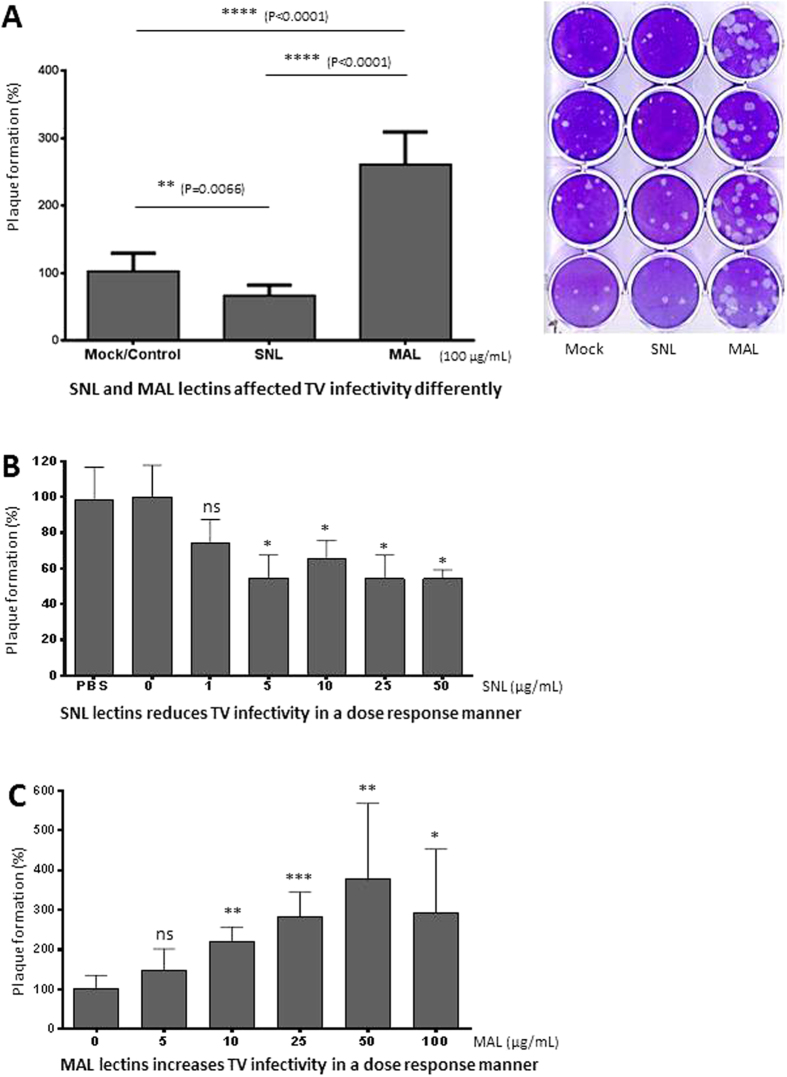
Sialic acid (SA)-binding lectins affected Tulane virus (TV) infectivity differently.(A) Sambucus nigra lectin (SNL) inhibited, while Maackia amurensis leukoagglutinin (MAL) increased TV infectivity in LLC-MK2 cells. Prior to TV infection, the LLC-MK2 cells were treated with SA-binding lectins; 100 μg/mL of SNL or MAL in 1x phosphate buffer saline (PBS, pH7.4). Mock control cells were treated with PBS only. The mean values (plaque numbers) of the mock/control group were set as 100%, while percentages (%) of the plaque numbers for individual wells of both mock/control and neuraminidase-treatment groups relative to the mean values of the mock/control group were calculated and shown. The statistical differences between data groups are indicated. Each experiment was repeated at least eight times. (B and C) Dose-response effects of SNL and MAL at different concentrations on TV infectivity in LLC-MK2 cells. The mean value (plaque numbers) of the control group without SNL (B) or MAL (C) treatment (0 μg/mL) was set 100%, while the reduction (B) or enhancement (C) rates (%) of the SNL/MAL treatment groups were calculated and shown. Each experiment was repeated at least four times. The statistical differences between the control groups (0 μg/mL SNL/MAL) and the SNL/MAL treatment groups are indicated. “ns”, “*”, “**”, and “***” indicate P values > 0.05, <0.05, <0.01, and <0.001, respectively.